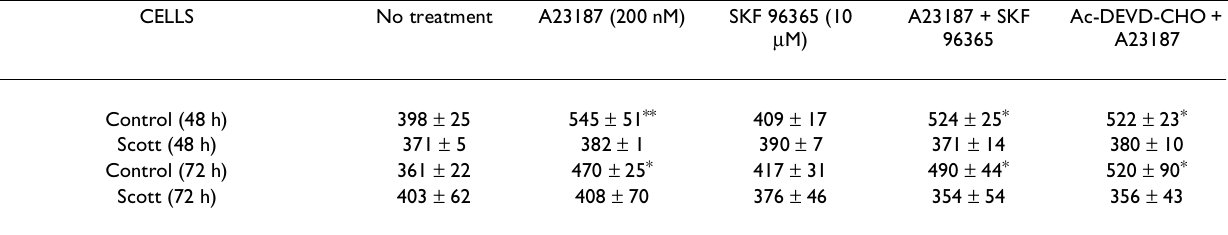
Table 1: Changes of intracellular Ca 2+ concentration in the cell population with elevated [Ca 2+ ] i , assessed by flow cytometry using Fluo- 3fluorescence (arbitrary units) in control and Scott cells after 48 or 72 h of apoptosis induction by calcium ionophore A23187 (200 nM) or/and SKF 96365 (10 µ M), in the absence and presence of the caspase inhibitor Ac-DEVD-CHO (50 µ M). Values are the mean ± SEM of 4 independent experiments.